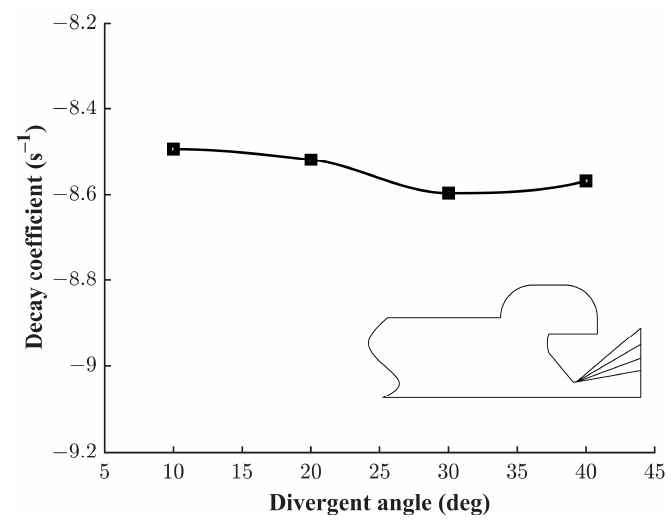
Figure 13. The decay coefficient under different divergent angle.